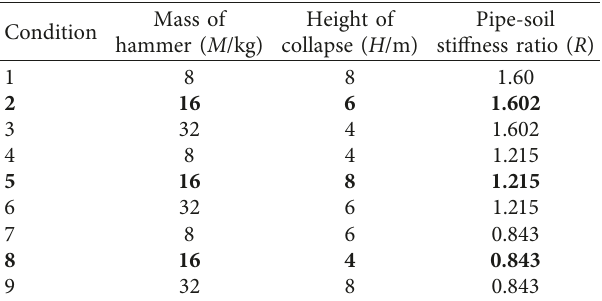
Table 3: Impact experiment scheme of the buried pipeline.